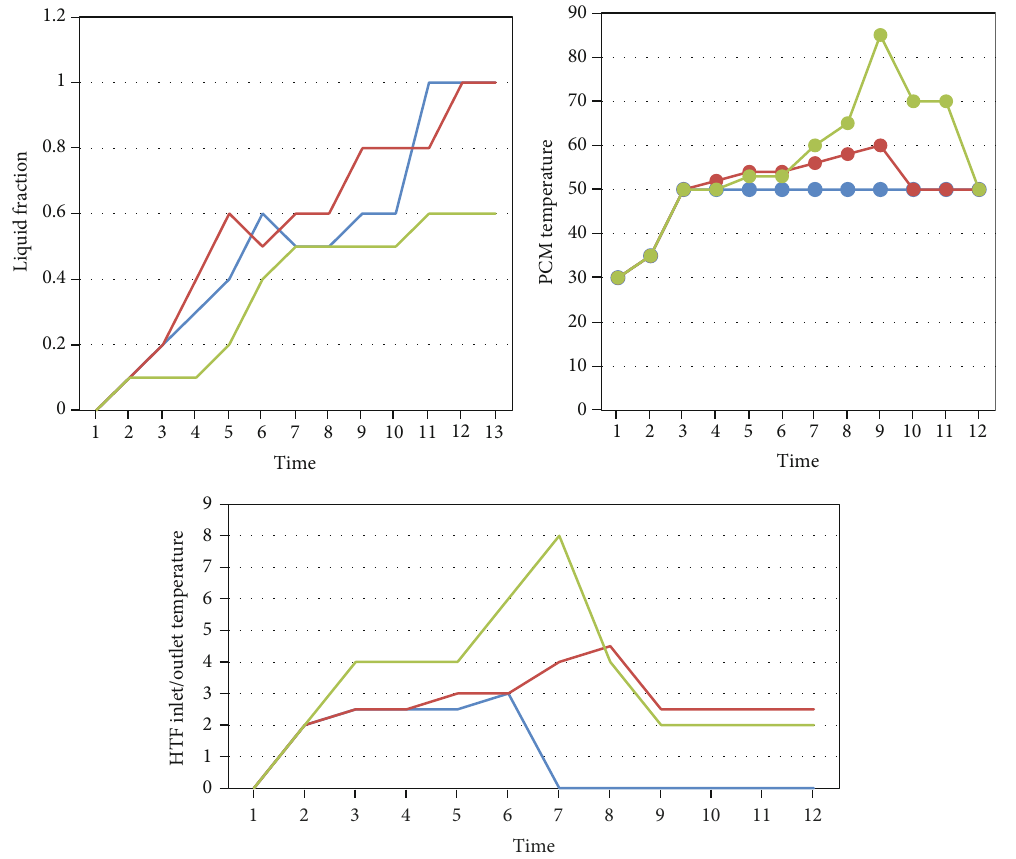
Figure 6: Mass fl ow rate evaluation of heat transfer fl